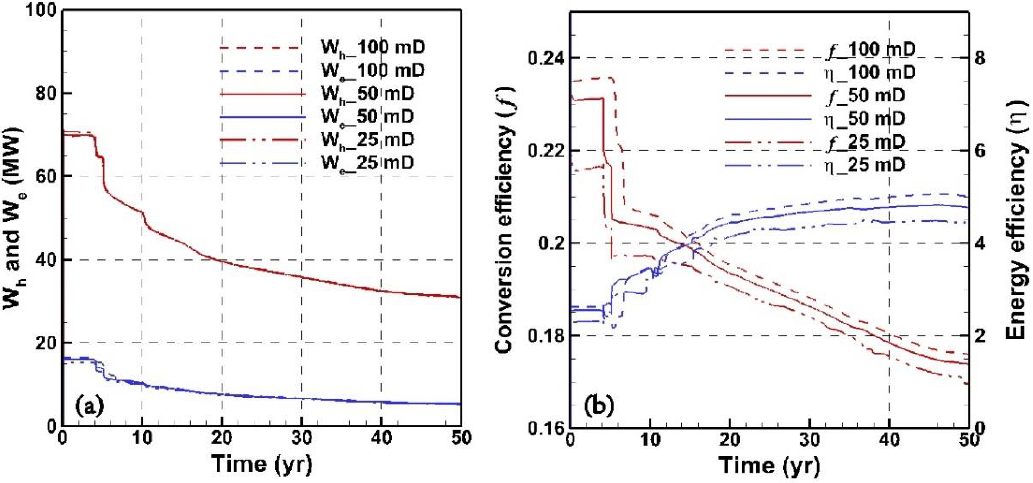
Figure 9. The evolution of net heat flow ( W h ), power generation ( W e ) ( a ), and conversion efficiency and energy efficiency ( b ) with different reservoir permeabilities.